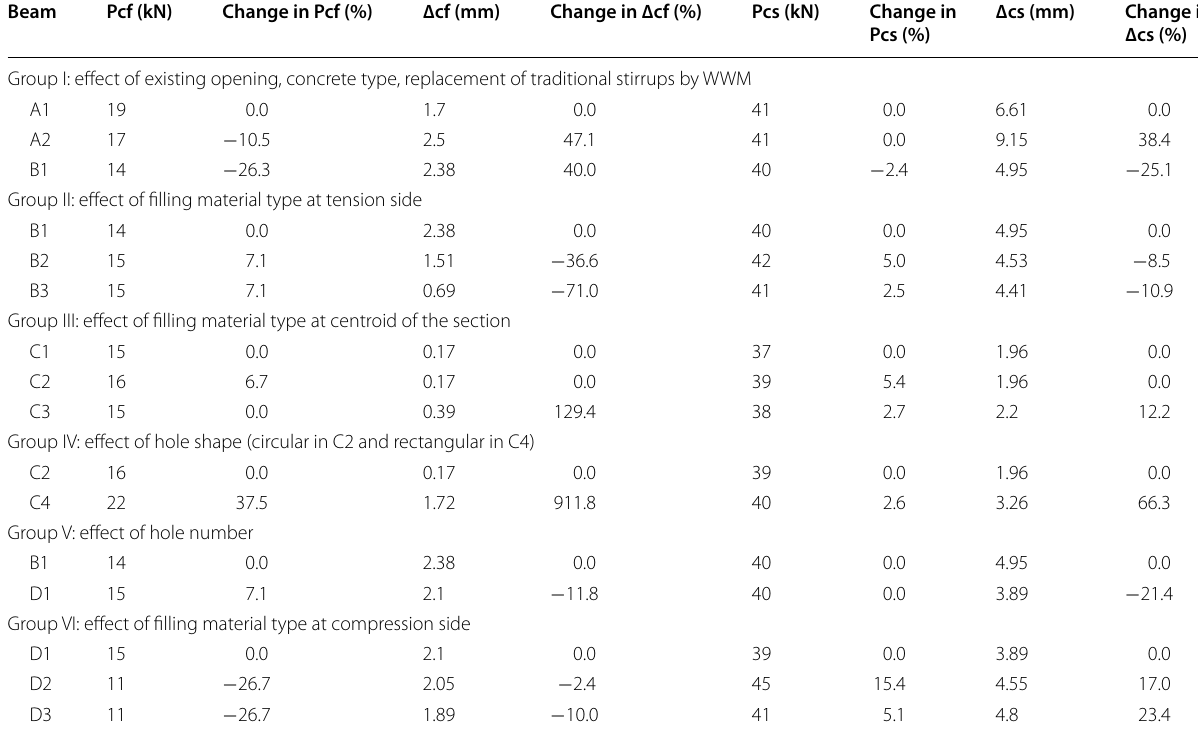
Table 6 Results analysis at cracking stage